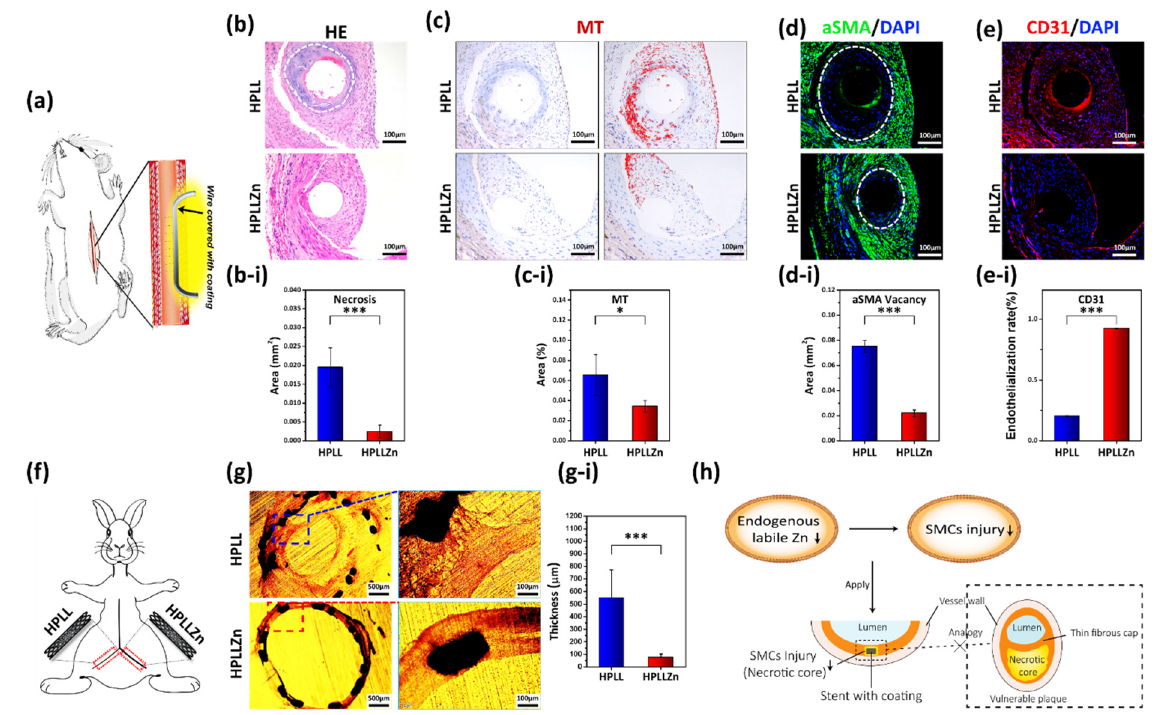
Figure 5. ( a ) Schematics of stainless-steel wires with different coatings implanted into Sprague Dawley rats’ abdominal aorta. ( b ) Hematoxylin and eosin staining and ( b-i ) quantification of the necrotic area surrounding the different coatings (the white dotted line shows the necrotic area). ( c ) Immunohistochemical of metallothionein protein expression and ( c-i ) semiquantitative analysis of the area (red marks regions with high MT expression). ( d ) The expression edge of α -SMA (green) and ( d-i ) quantification of the area without α SMA in the tissue close to the coating after a 1-month implantation (the white dotted line shows the edge closest to the coating). ( e ) Immunofluorescence staining of CD31 and ( e-i ) the endothelialization integrity. ( f ) Schematics of vascular stents with different coatings implanted in New Zealand white rabbits’ iliac artery. ( g ) Histomorphometric analysis of stents after a 1-month implantation and ( g-i ) quantification of the mean neointimal thickness. ( h ) The potential mechanism of this rule applies to the cardiovascular stent. (HE, hematoxylin and eosin stain; MT, metallothionein; α -SMA, α -smooth muscle actin; CD31, cluster of differentiation 31; DAPI, 2-(4-Amidinophenyl)-6-indolecarbamidine dihydrochloride; data were analyzed using 1-way ANOVA, * p < 0.05, ** p < 0.01, *** p < 0.001; ns, not significant).